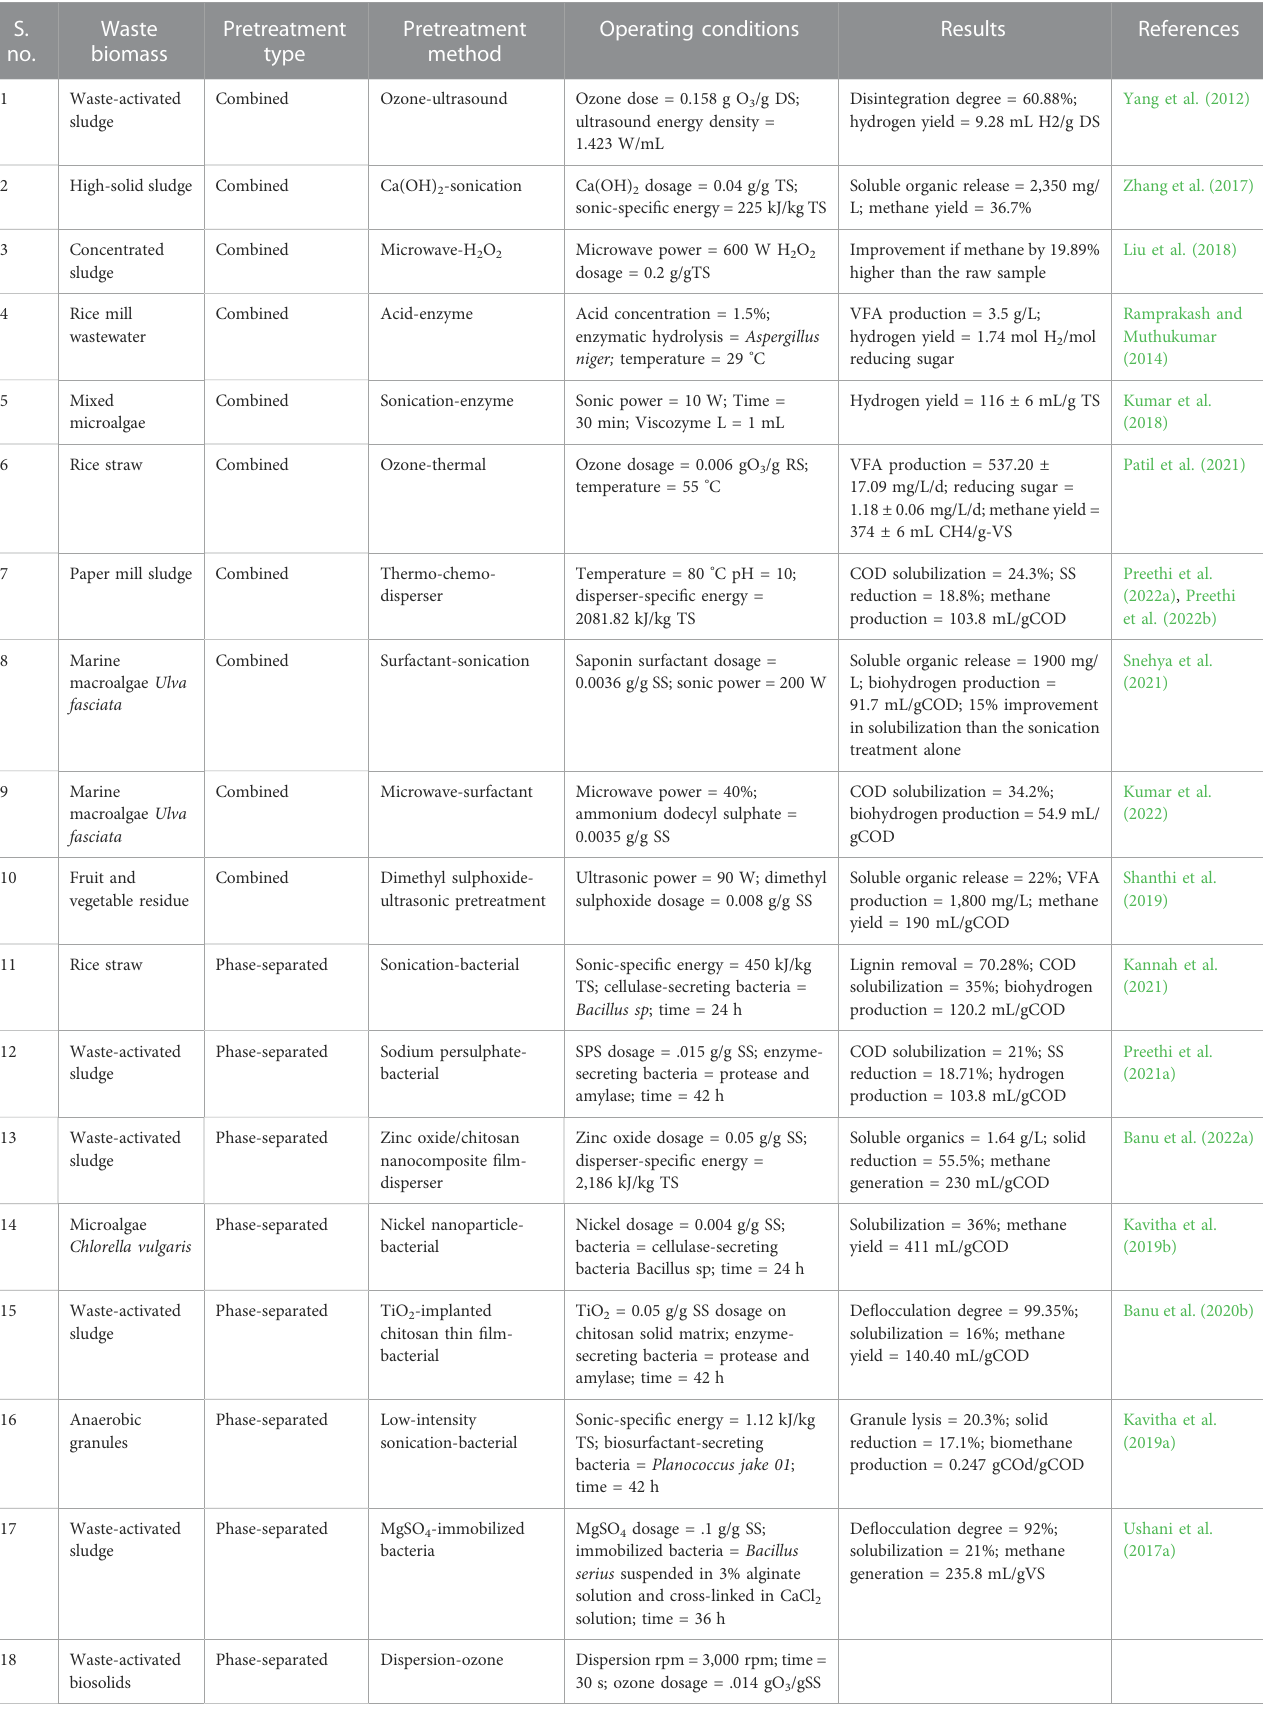
TABLE 1 Different combined and phase-separated pretreatment methods responsible for bioenergy production. S.